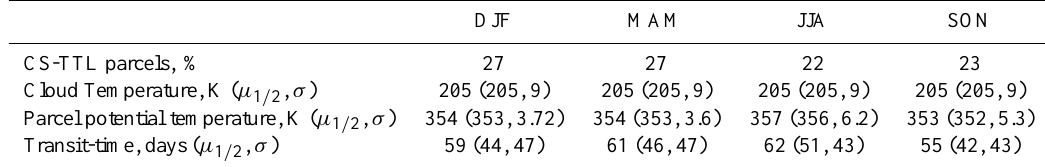
Table 1. Seasonal mean characteristics of convective sources and times for transport of air between detrainment and launch. Calculations made using the ALLSKY- 1T 0 trajectory ensemble, launched at 100hPa. The values for the median, µ 1 / 2 , and standard deviation, σ , are given in parenthesis.